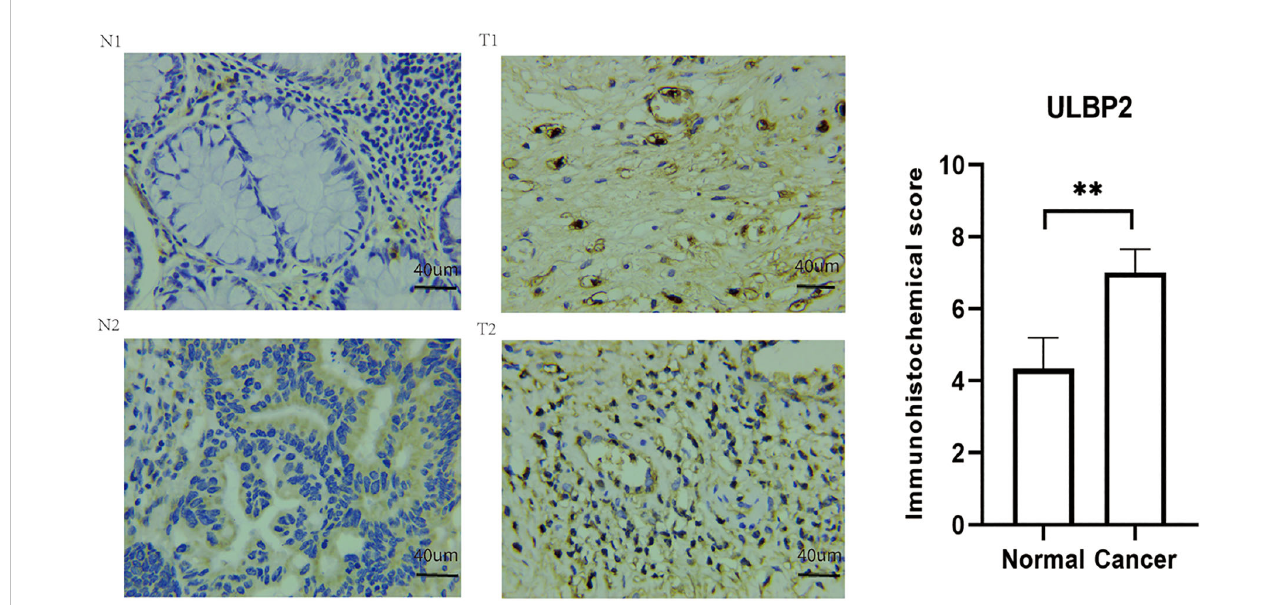
FIGURE 3 Immunohistochemical staining of ULBP2 in colon cancer tissues and adjacent healthy tissues. N: adjacent normal tissue, T: colon cancer tissue. ** P < 0.01.